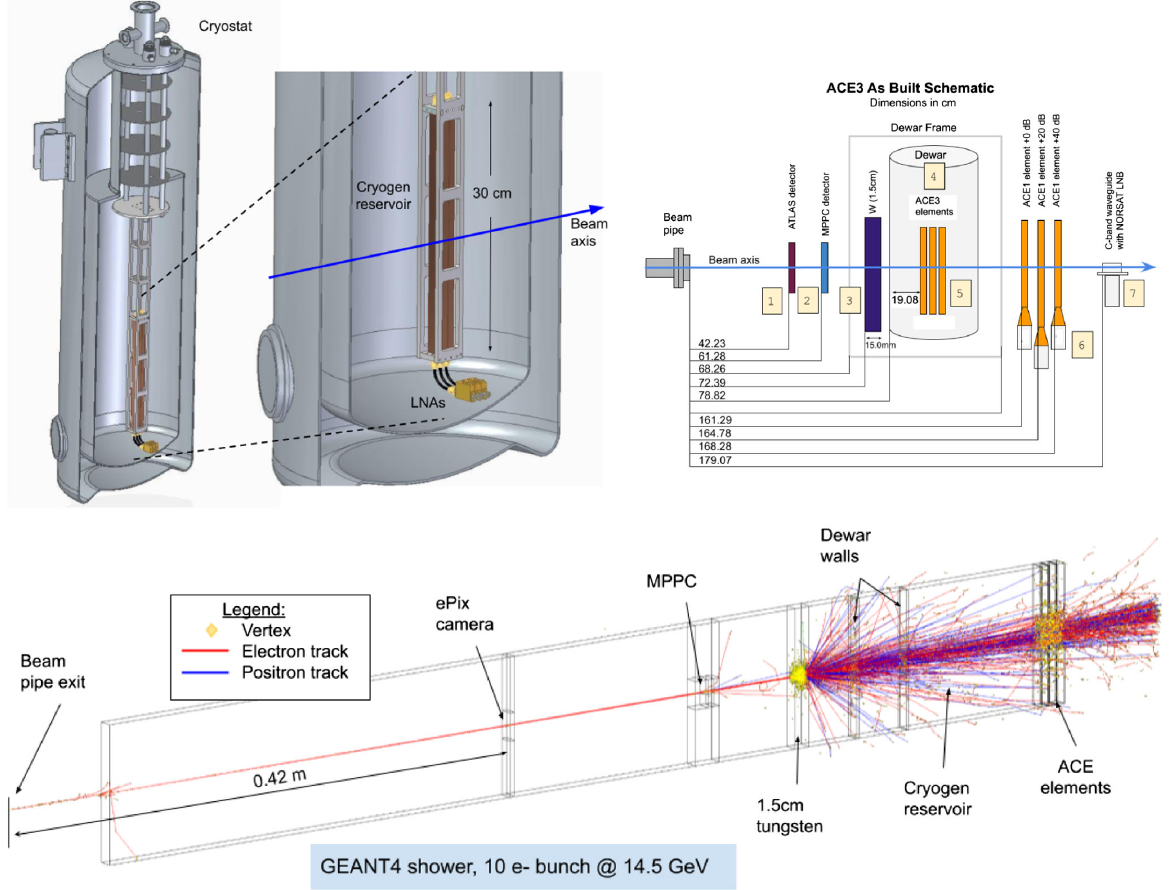
FIG. 2. Upper left: a rendering of the dewar containing the ACE elements, and an expanded view of the 60-cm long active section, which includes three WR51 waveguide elements. Upper right: Dimensions in cm of the different portions of the experimental setup. Bottom: a GEANT 4 simulation slice through the system from the beam pipe exit to the ACE elements within the dewar. This shows the charged portion of the electromagnetic shower for a bunch with ten electrons of 14.5 GeVenergy each. Electrons are in red, positrons in blue, and each interaction vertex is marked with a yellow